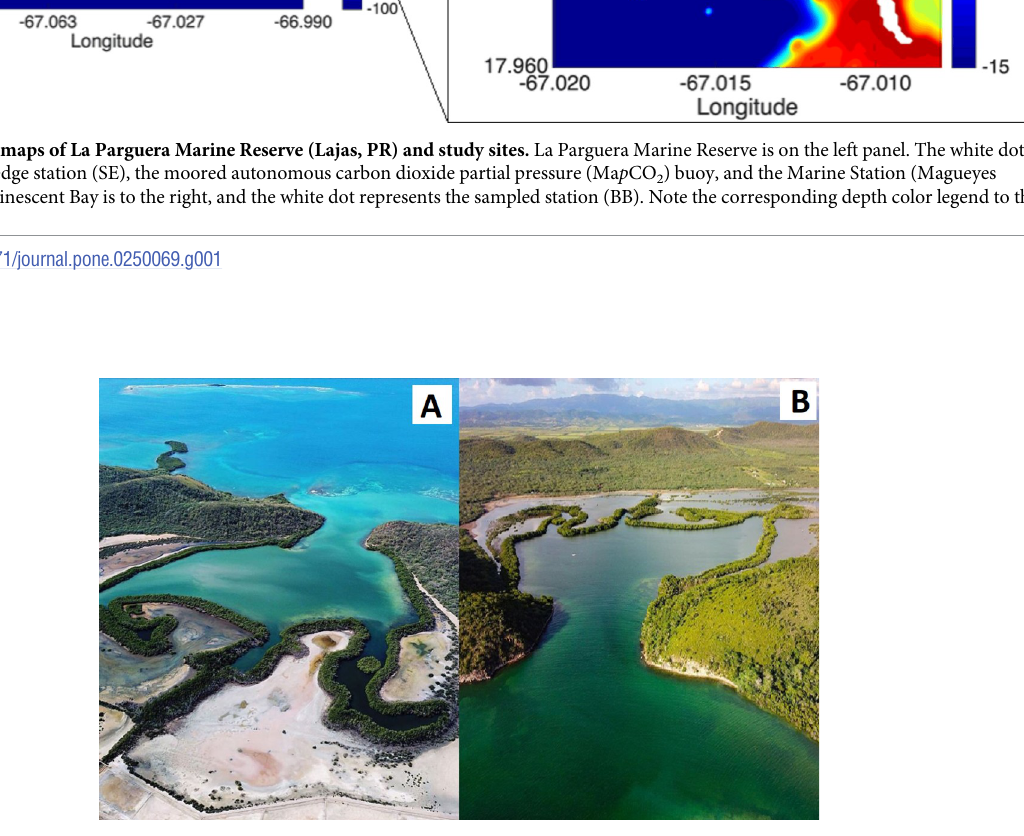
PLOS ONE | https://doi.org/10.1371/journal.pone.0250069 May 5,